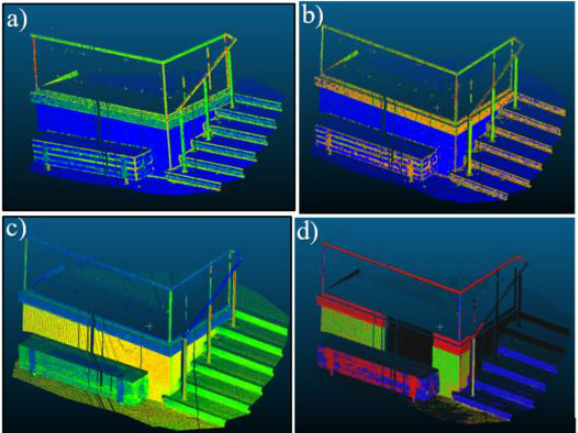
Figure 7: a) ANN curvature b) k-means curvature c) ANN